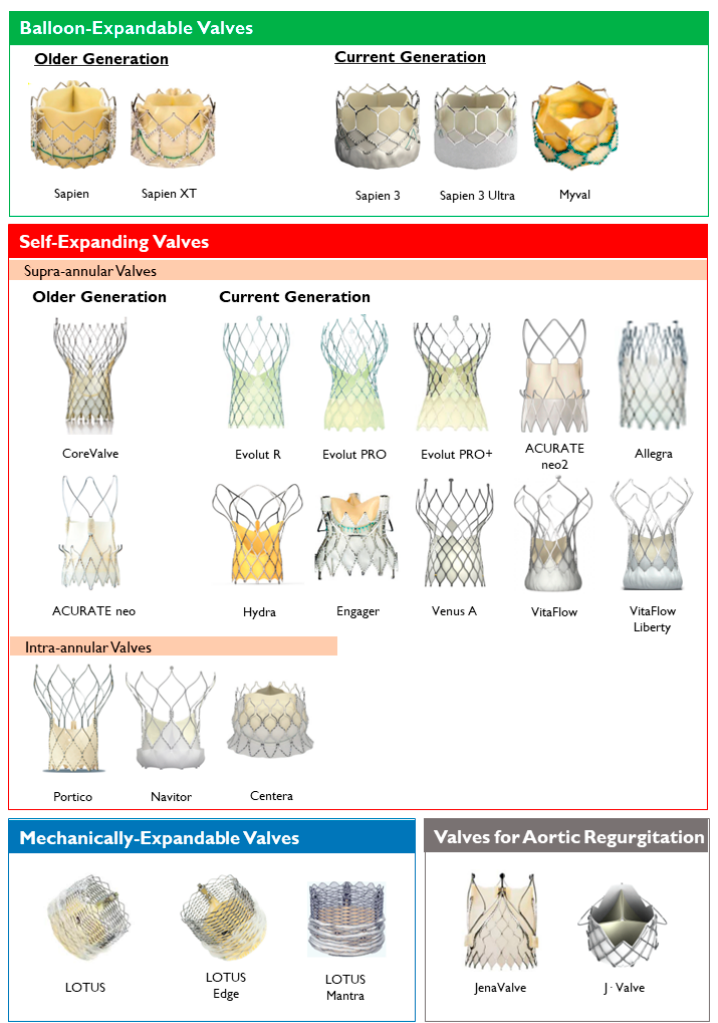
Figure 2. Transcatheter heart valves, stratified by mechanism of the valve frame expansion and leaflets position.